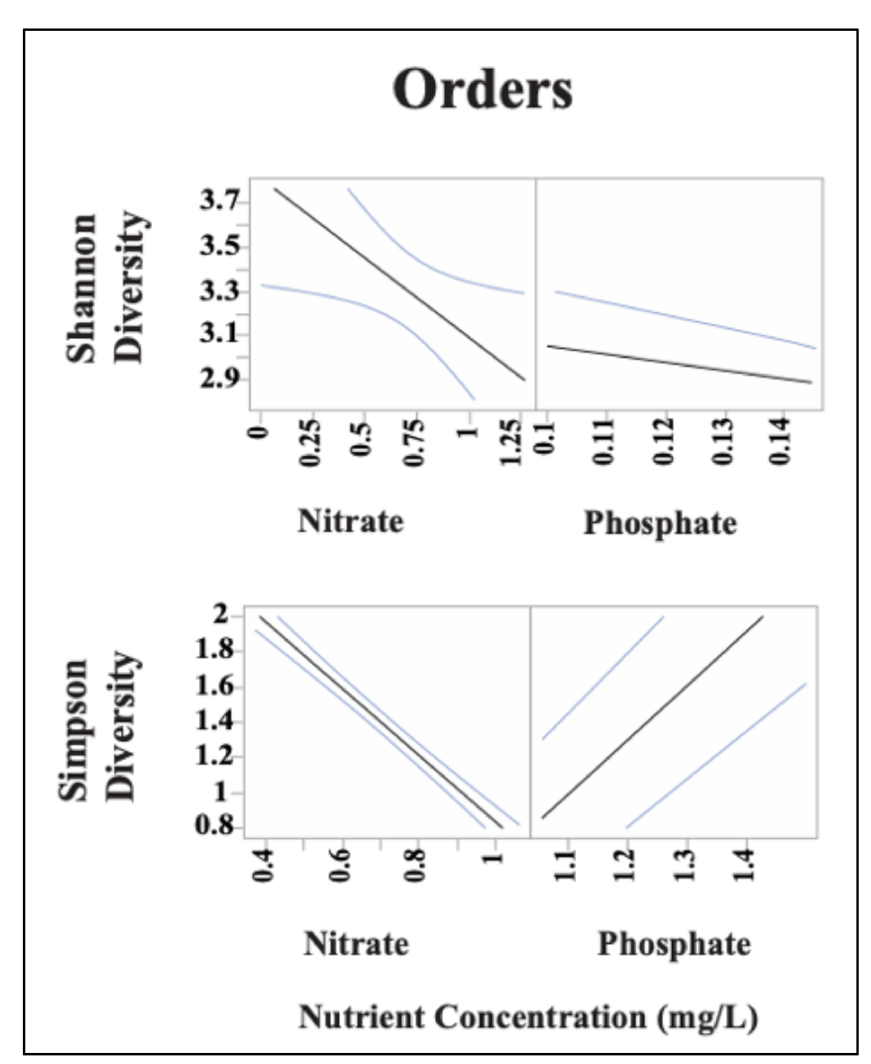
Figure 5. Prediction profiles from ANOVA, showing the effect of measured nitrate and phosphate concentration (mg/L) on the Shannon and Simpson diversity indices identified as taxonomic order out of wetland sites 1–6 during summer 2017. The blue-lined area in each profile represents the 95% confidence prediction interval of the response variable. The profiler was set for median ambient conditions, with 2.19 nitrate at mg/L and phosphate at 0.27 mg/L in the case of Shannon and Simpson diversity,